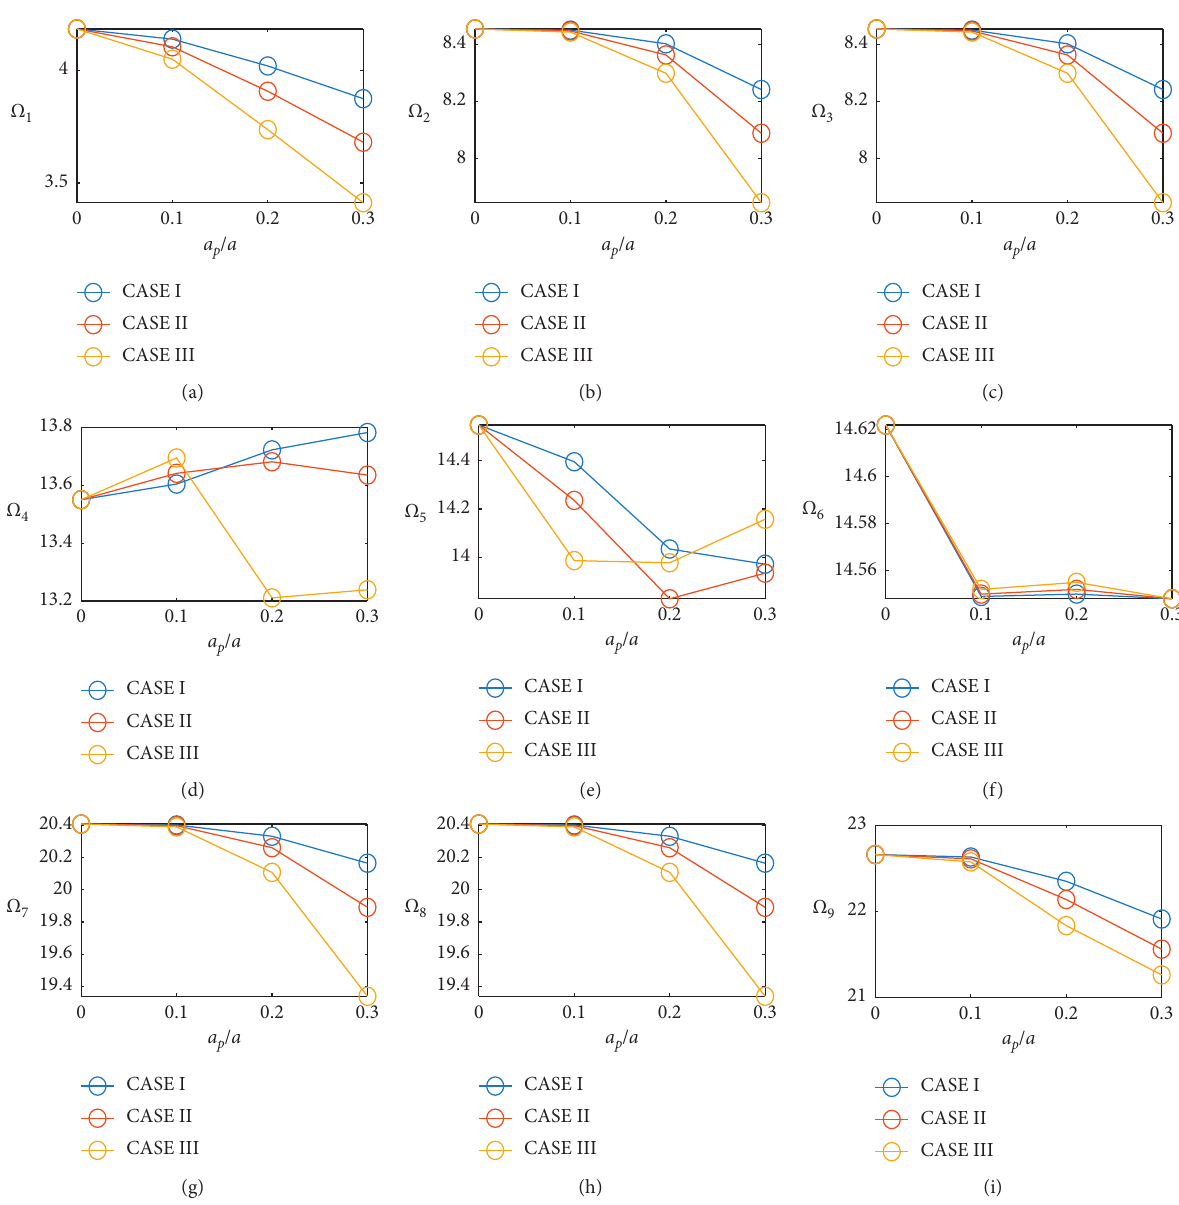
Figure 5: Nondimensional frequencies of the angle-ply laminate ([45/ − 45]s) with CCCC boundary condition, E 1/ E 2 � 20, and a � b � 10h and for different patch sizes and